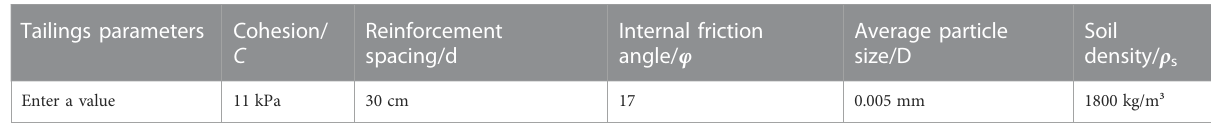
TABLE 3 Tailings parameter setting